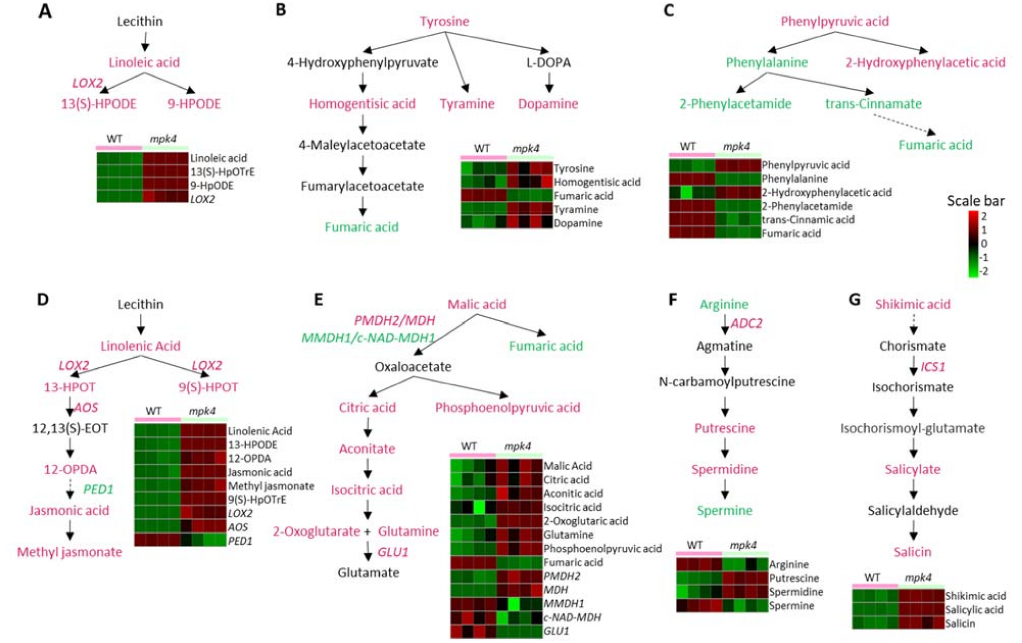
Figure 4. Pathways with differential metabolites and proteins between WT and the mpk4 mutant. ( A ) Linoleic acid metabolism. ( B ) Tyrosine metabolism. ( C ) Phenylalanine metabolism. ( D ) Alpha- Linolenic acid metabolism. ( E ) Citrate cycle. ( F ) Arginine and proline metabolism. ( G ) Salicylic acid synthesis. red: increased in mpk4 ; green: decreased in mpk4 ; solid arrow: direct reaction; dotted arrow: multiple reaction